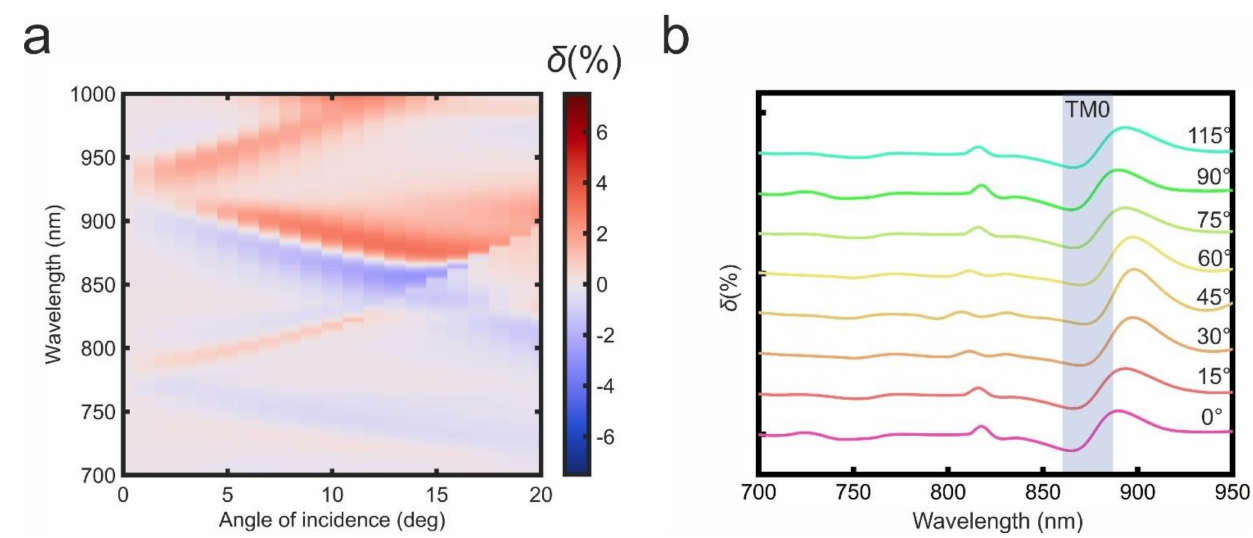
Figure A3. Numerically simulated TMOKE spectra as a function of θ ( a ) and for fixed θ = 10 ◦ as a function of the sample rotation angle ϕ ( b ). All curves in ( b ) have offsets to clarify representation.